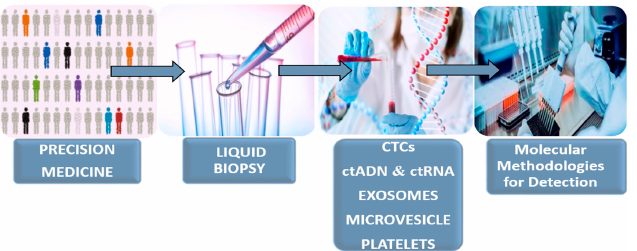
Figure 1. Operative flow of the liquid biopsy: individualized therapeutic strategy for capture dynamics of the tumoral disease.